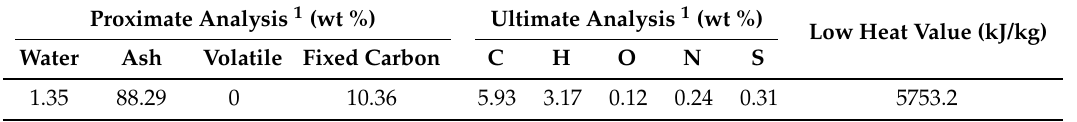
Table 3. Proximate and ultimate analysis of the solid residue.